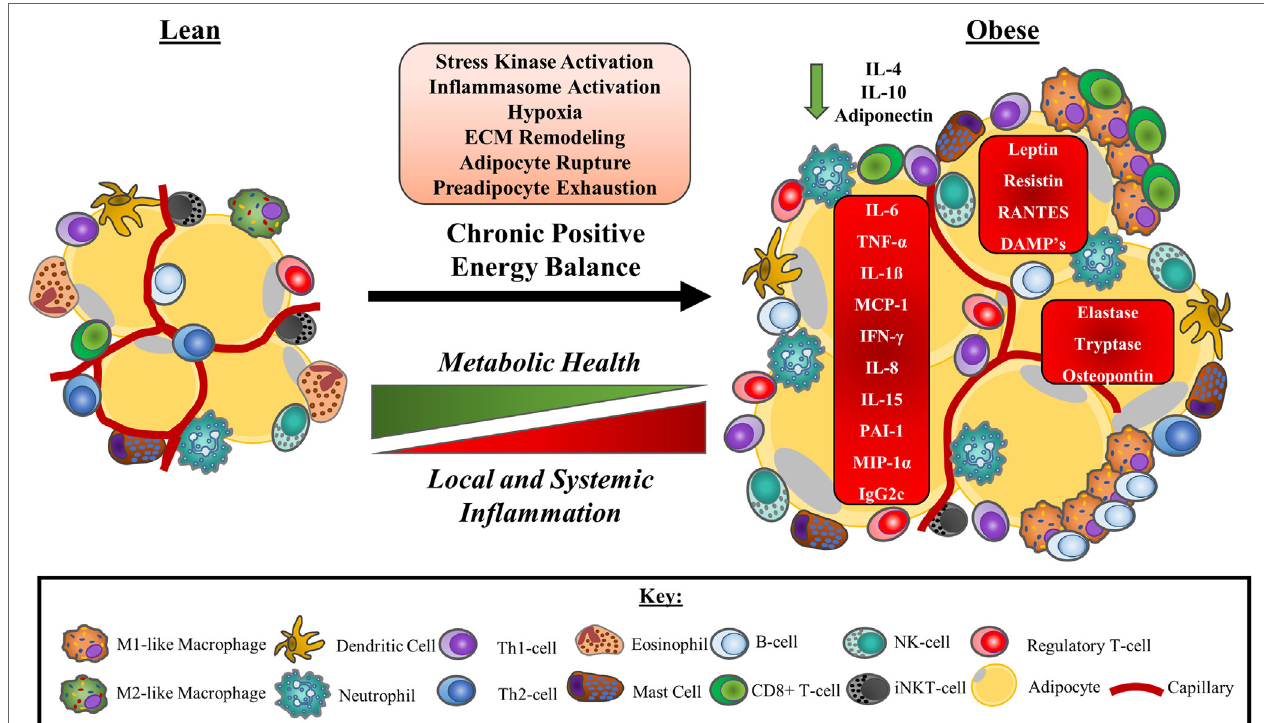
FiGURe 3 | A model of obesity-driven immunological changes within adipose tissue. Under a chronic state of positive energy balance, adipose tissue undergoes a multitude of changes that include the hypertrophic expansion of adipocytes without concurrent angiogenic responses. The consequences of these adaptations include local tissue hypoxia as a result of reduced tissue blood flow and impaired oxygen delivery. The rapid expansion of adipocytes also leads to unstable adipocytes prone to rupturing, releasing their lipid contents. This instability is further exacerbated by an exhaustion of the preadipocytes required to facilitate adipose tissue expansion. The net result of these physiological changes to adipocytes is the release of DAMPs and other signalling molecules that initiate stress kinase activation and promote monocyte infiltration to manage the remodelling of the ECM. Neutrophils are the first cells to accumulate in adipose tissue, followed by a range of other immune cells, most notably, B-cells, CD8 + T-cells, and M1-like/intermediate, or “double-negative” (CD11c − CD206 − ) macrophages that surround unstable adipocytes in crown-like structures. As a consequence, a Th-1 cell and M1-like macrophage secretion profile predominated and some anti-inflammatory immune cells such as eosinophils and iNKT-cells leave the tissue. Other anti-inflammatory cells, including regulatory T-cells, may increase to compensate. Pro-inflammatory cytokines and adipokines dominate the tissue microenvironment potentiating the activation of stress kinases and inflammasomes. Local inflammation reduces adipose tissue insulin sensitivity, impairing metabolic health and promoting ectopic lipid deposition. Pro-inflammatory adipose tissue contributes to the chronic, low-grade inflammation characteristic of obesity, and metabolic disease. Abbreviations: CD, cluster of differentiation marker; DAMP, damage-associated molecular pattern; ECM, extracellular matrix; IFN- γ , interferon gamma; Ig, immunoglobulin; IL, interleukin; iNKT-cell, invariant natural killer T cell; MCP-1, monocyte chemotactic protein 1 (CCL-2); MIP-1 α , macrophage inflammatory protein 1 alpha (CCL-3); PAI-1, plasminogen activator inhibitor 1; RANTES, regulated on activation, normal T-cell expressed and secreted (CCL-5); Th cell, helper T cell; TNF- α , tumour necrosis factor- α